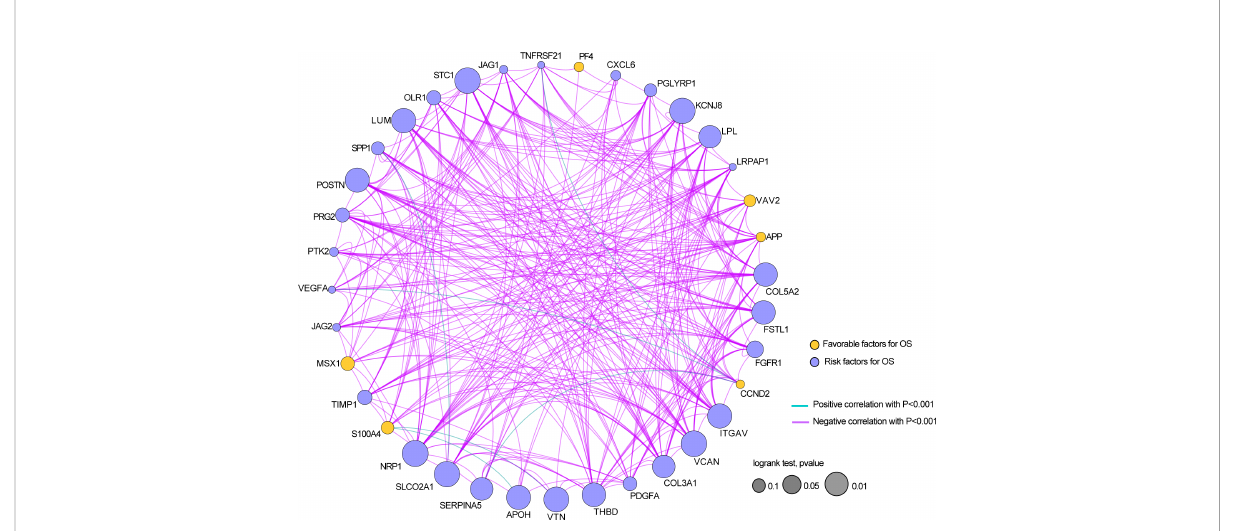
FIGURE 3 The relationship between the expressions of 36 angiogenesis-related genes in the STAD